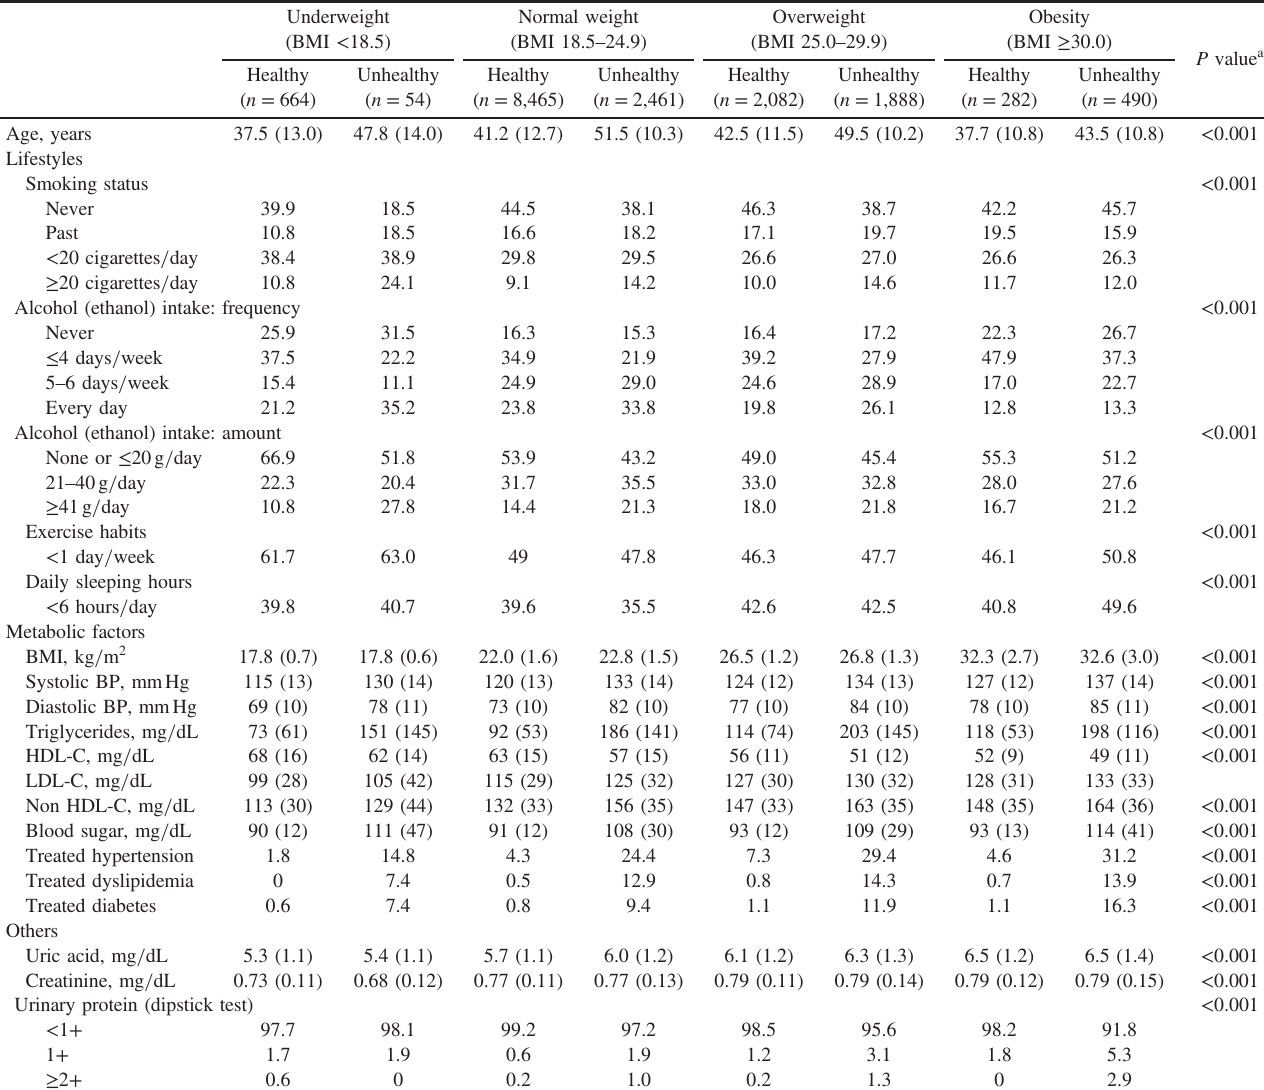
Table 1. Baseline characteristics according to BMI levels and metabolic health status Underweight Normal weight